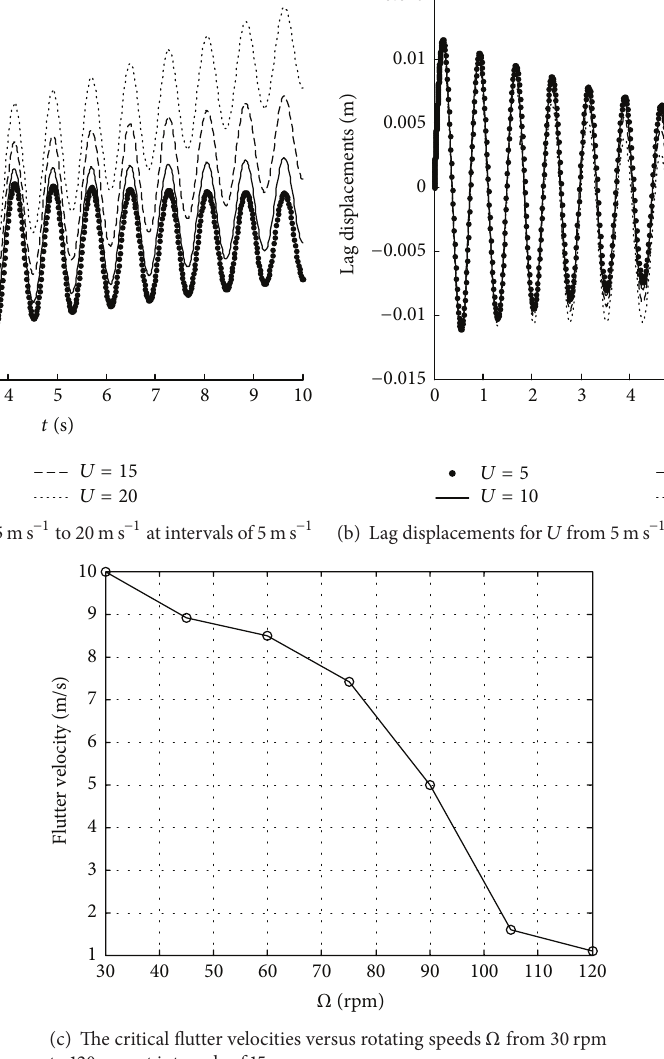
Figure 3: Flap and lag displacements for 𝑈 from 5 ms −1 to 20 ms −1 at intervals of 5m s −1 and critical flutter velocities of the section at given rotating